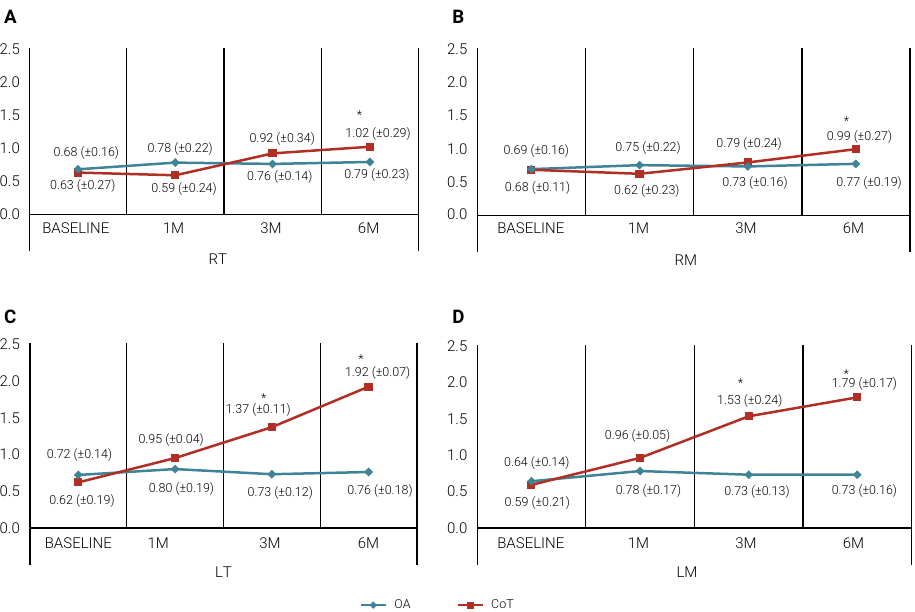
Figure 4. Pressure pain threshold (PPT) of (A) right temporalis (RT), (B) right masseter (RM), (C) left temporalis (RM), and (D) left masseter (LM). Mean ± standard deviation; *=P<0.5 among inter-group paired variables (three-way repeated measures ANOVA followed by Tukey´s multiple comparisons test). OA, occlusal appliance; CoT, combined